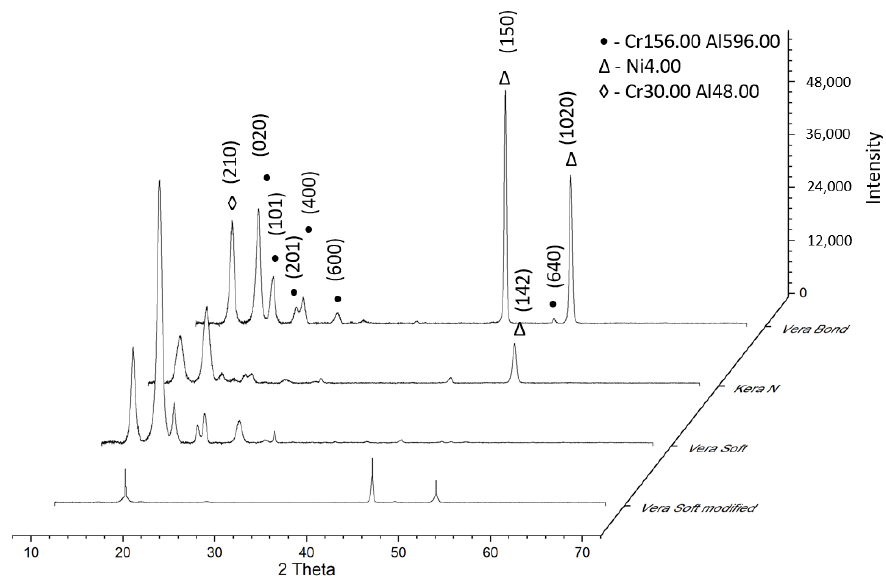
Figure 5. Diffractograms of experimental alloys